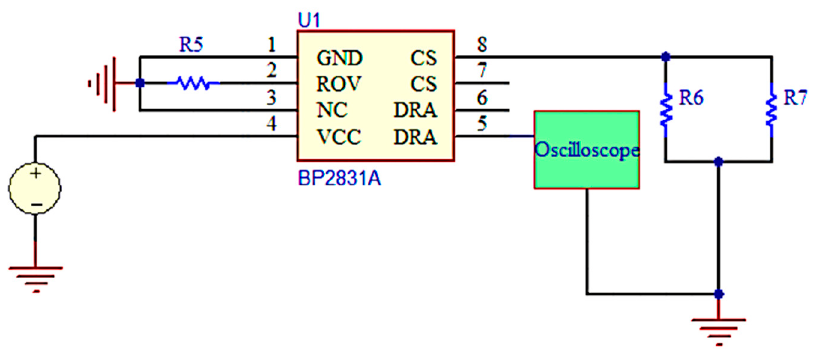
Figure 8. Test circuit of the MOSFET controlled by VCC (Sample A).